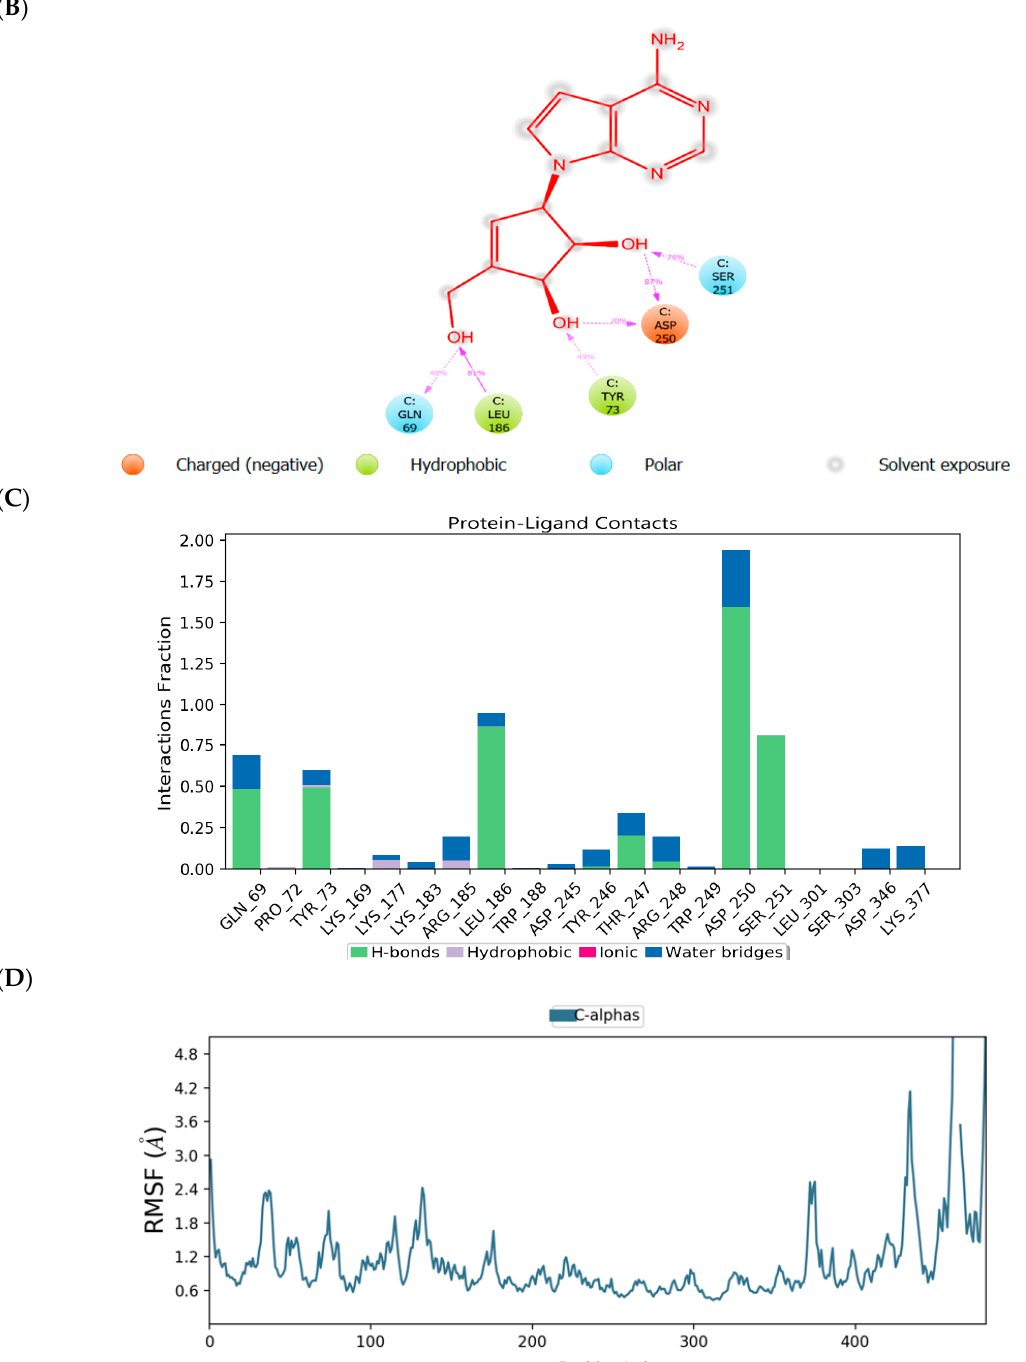
Figure 7. ( A ) MDSs trajectory output revealing the root-mean-square deviation (RMSD) plot of CID-57930781 bound to MNV RdRp; ( B ) Binding interaction of CID-57930781 -MNV RdRp after MDSs; ( C ) Ligplot representing interaction of CID-57930781 with different residues of MNV RdRp throughout the simulation trajectory ( D ) Graphical depiction of root-mean-square fluctuation (RMSF) of CID-57930781 with different residues of MNV RdRp.